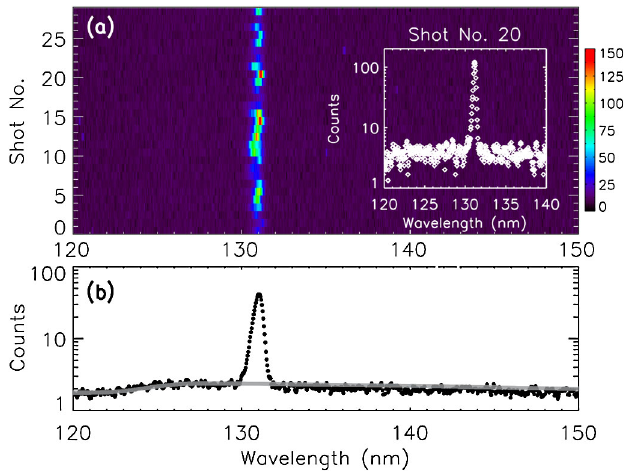
FIG. 3. A series of single shots taken at the 2nd harmonic at 131 nm (a) and the time averaged intensity over these 30 shots (b). A single shot spectrum is depicted in the inset. The calcu- lated incoherent undulator harmonic was fitted for the pulse energy calibration [gray line in (b)]. These measurements were done before stability improvements on laser-electron